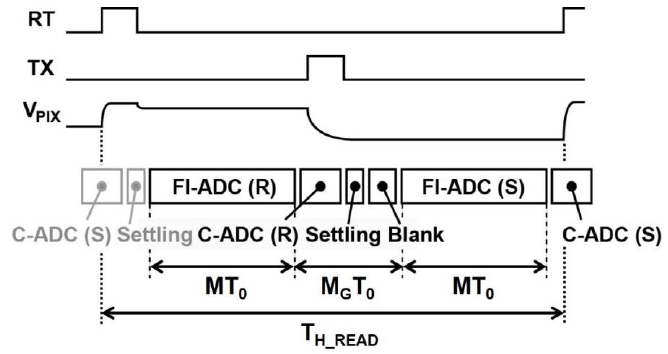
Figure 14. Noise components as a function of the sampling number in the folding-integration ADC.